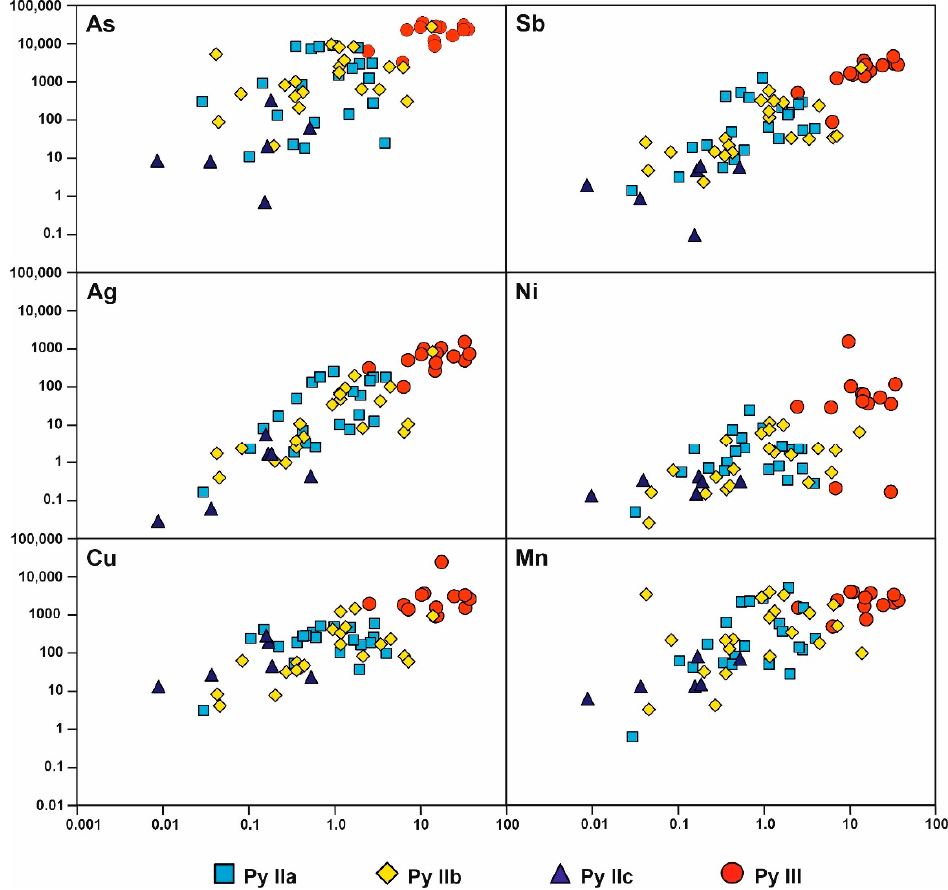
Figure 7. Scatter diagrams (log scale) showing the relationships between Au and As, Sb, Ag, Cu, Ni and Mn in different textural types of pyrite.